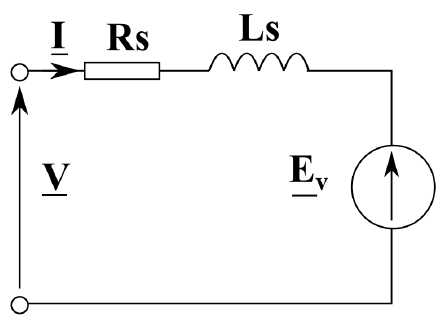
Figure 25. Electric model RLE.